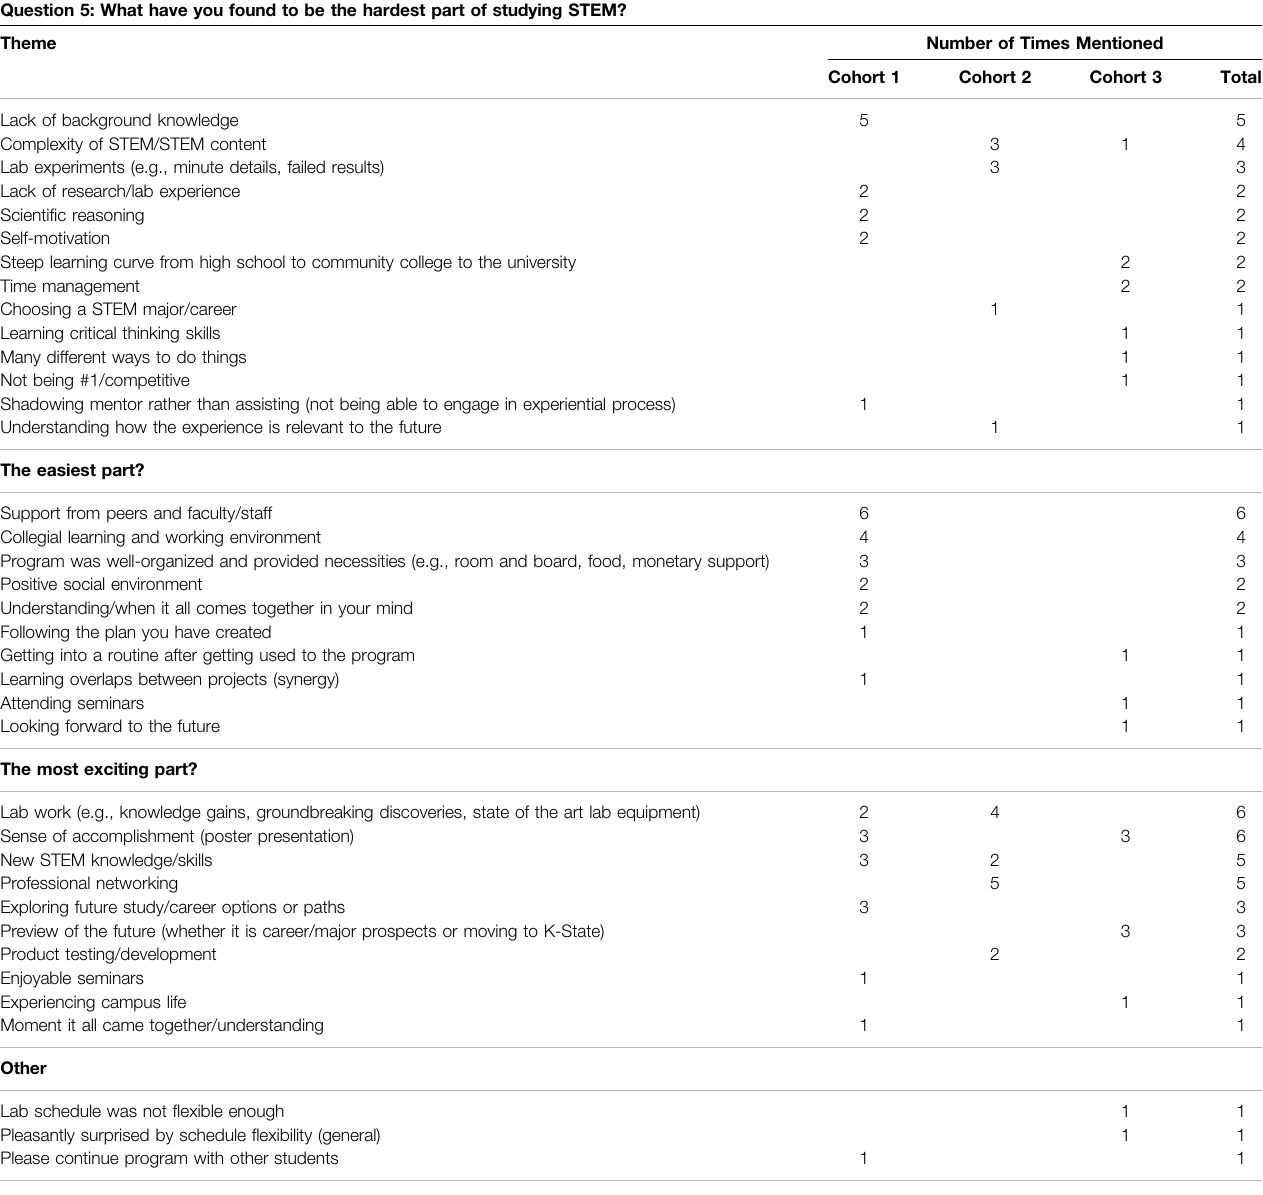
TABLE 12 | Themes mentioned in the focus group discussion in response to Question